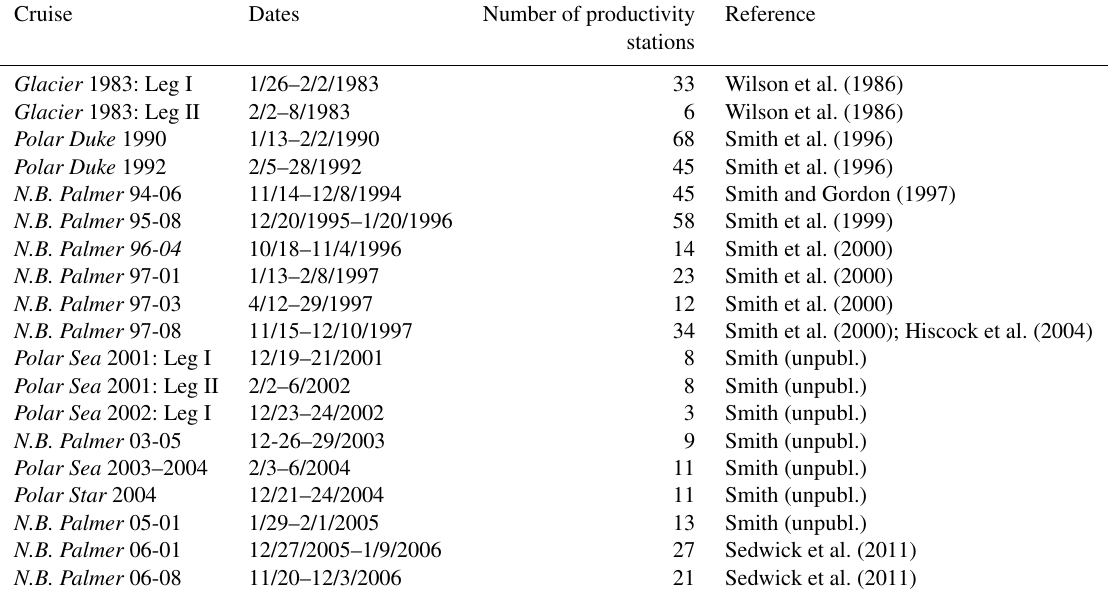
Table 1. Name of the cruises and dates in which 14 C productivity measurements were made, along with the number of stations completed and the reference that published those